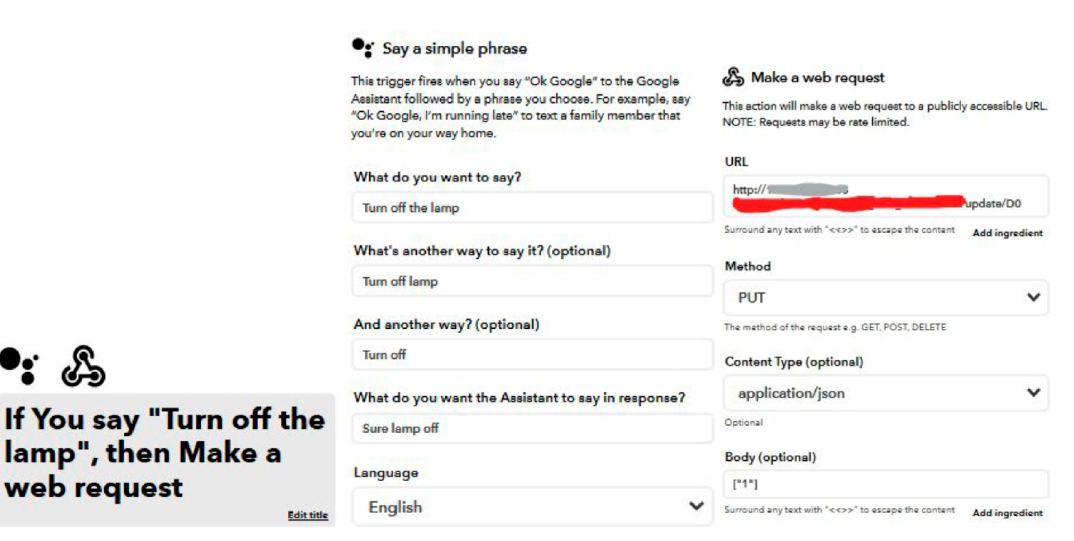
Figure 6. IFTTT trigger turn off.